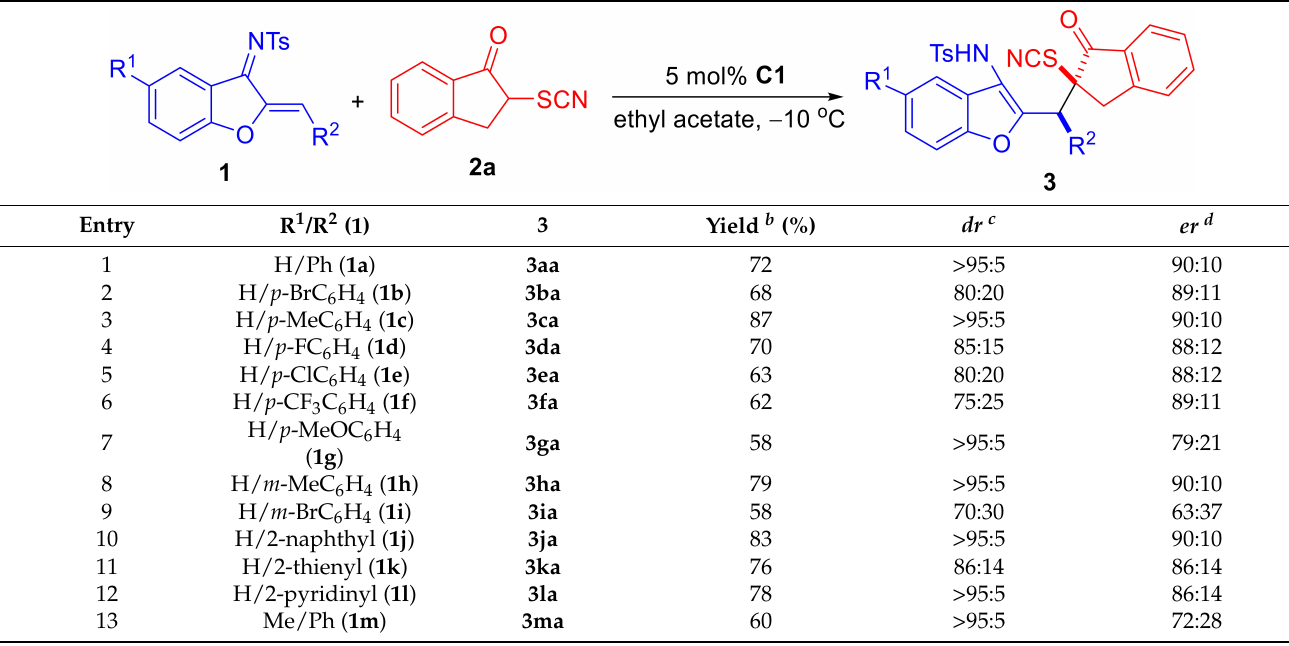
Table 2. Substrate scope of azadienes a